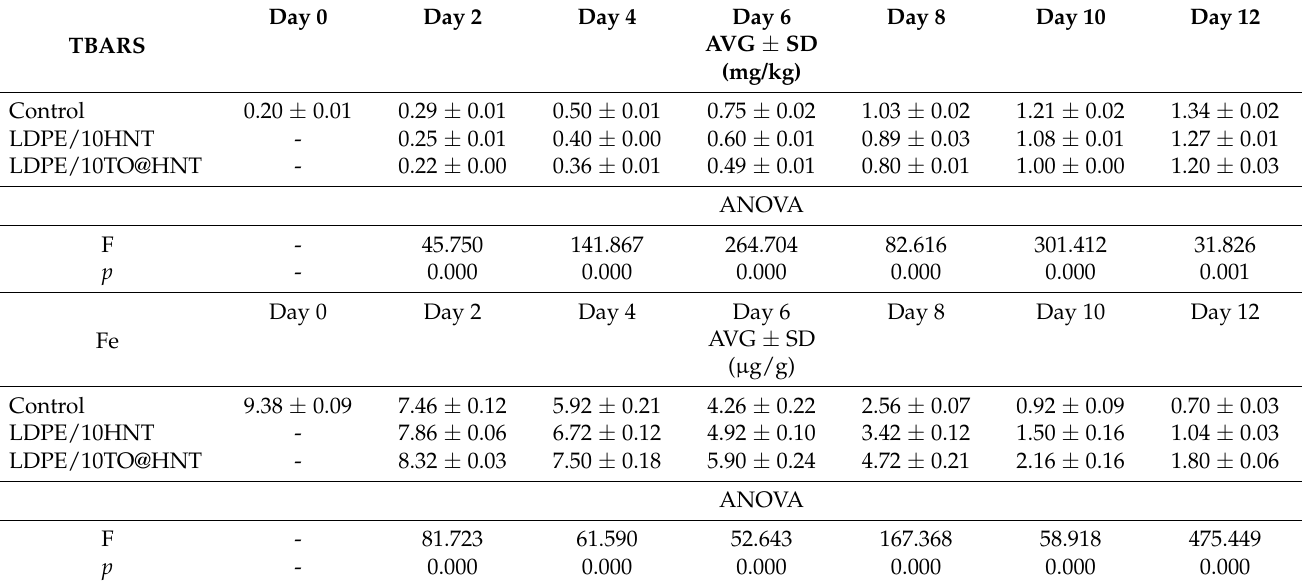
Table 3. TBARS and heme iron content of “scaloppini” pork meat in different packaging systems with respect to storage